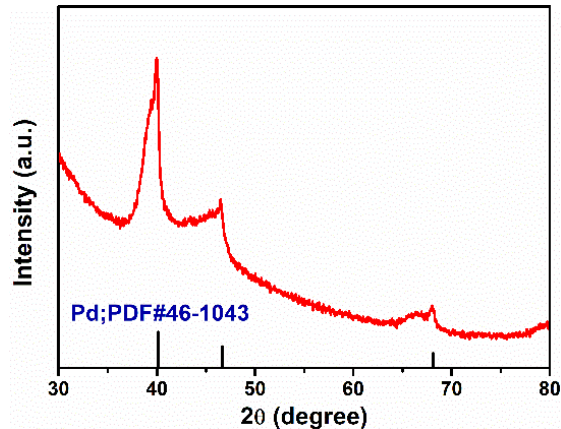
Figure 1. XRD pattern of the Pd/NAC catalyst .